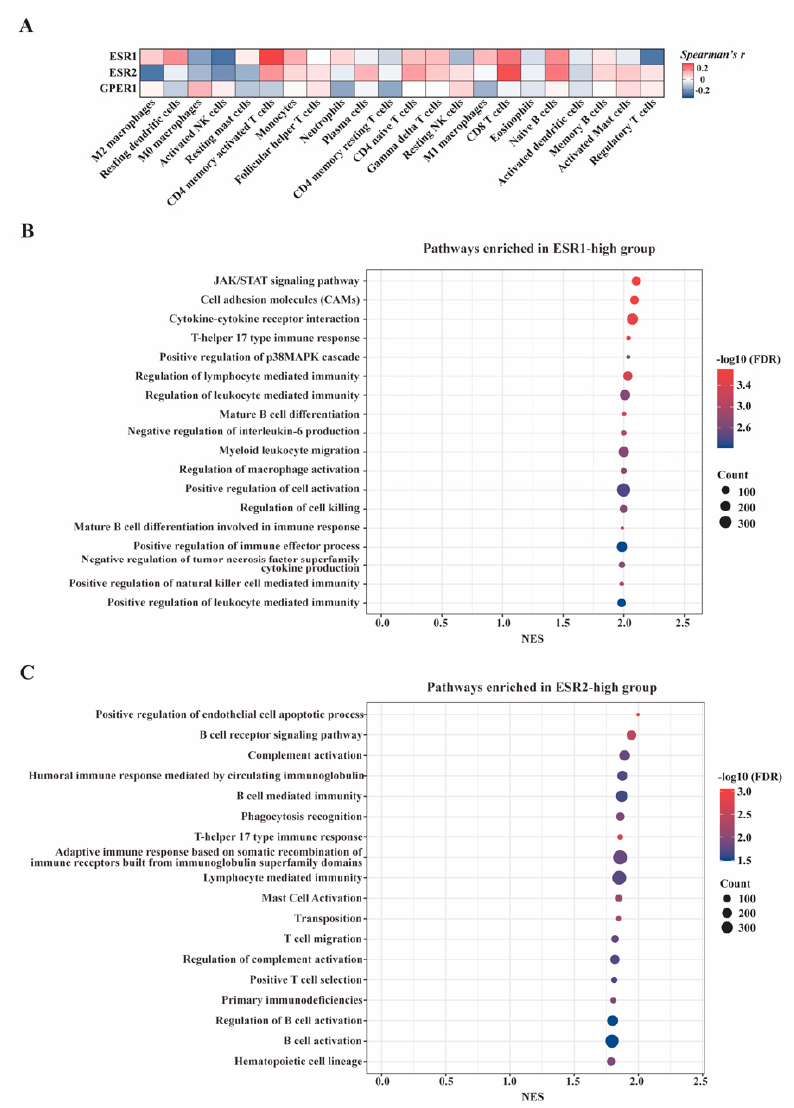
Figure 6. In silico functional exploration of ERs in PAAD. ( A ) Heatmap showing the association between ERs gene expression levels and proportions of 22 immune cell types in tumor microenvironment. ( B ) Diagram of the pathways enriched in the ESR1-high group; the median of gene expression was used as a cutoff value for sample classification. ( C ) Diagram of the pathways enriched in the ESR2-high group.